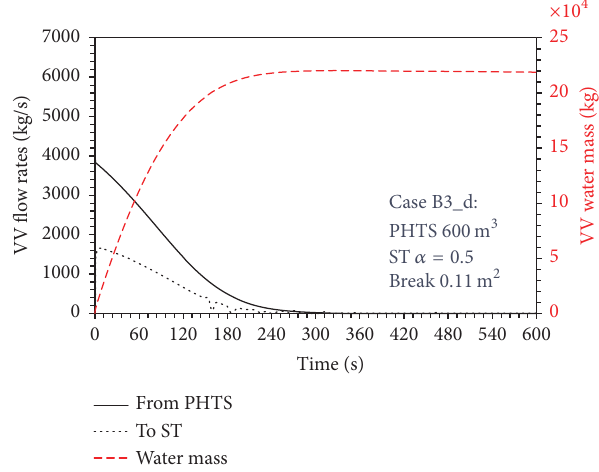
Figure 13: Break and relief flow rates and mass inventory in the VV (larger break).